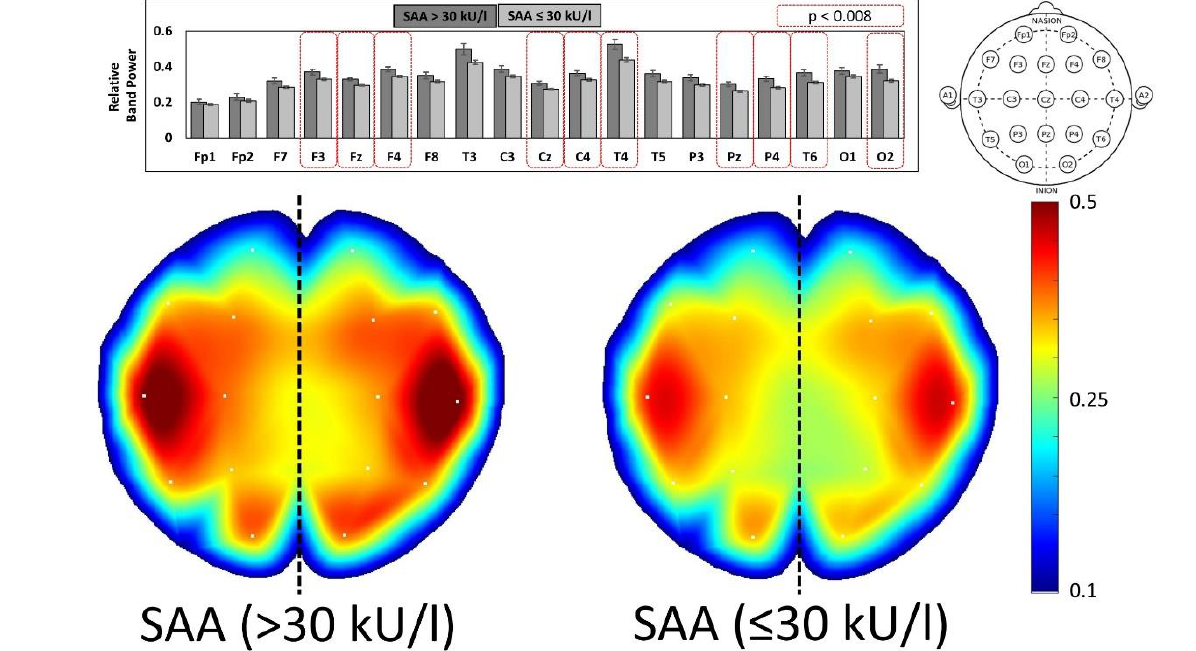
Fig. 7. The topographic of beta-band brain waves corresponds to the two categories of salivary amylase